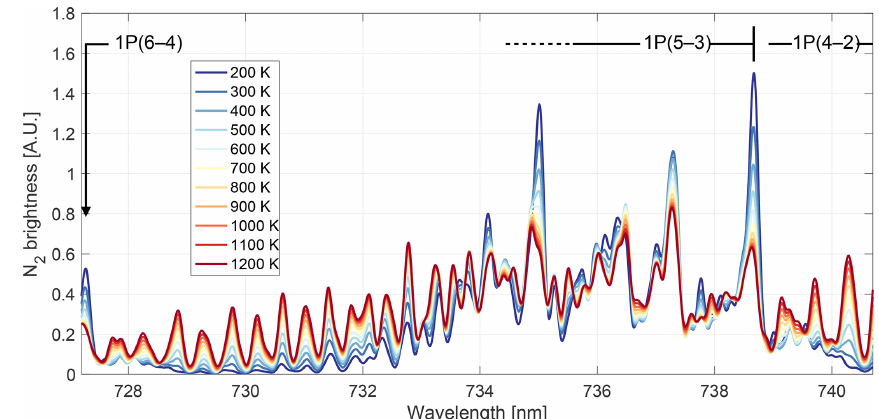
Figure 4. Synthetic N 2 spectra at different rotational temperatures. The rotational band and, where present, band heads are labelled above the